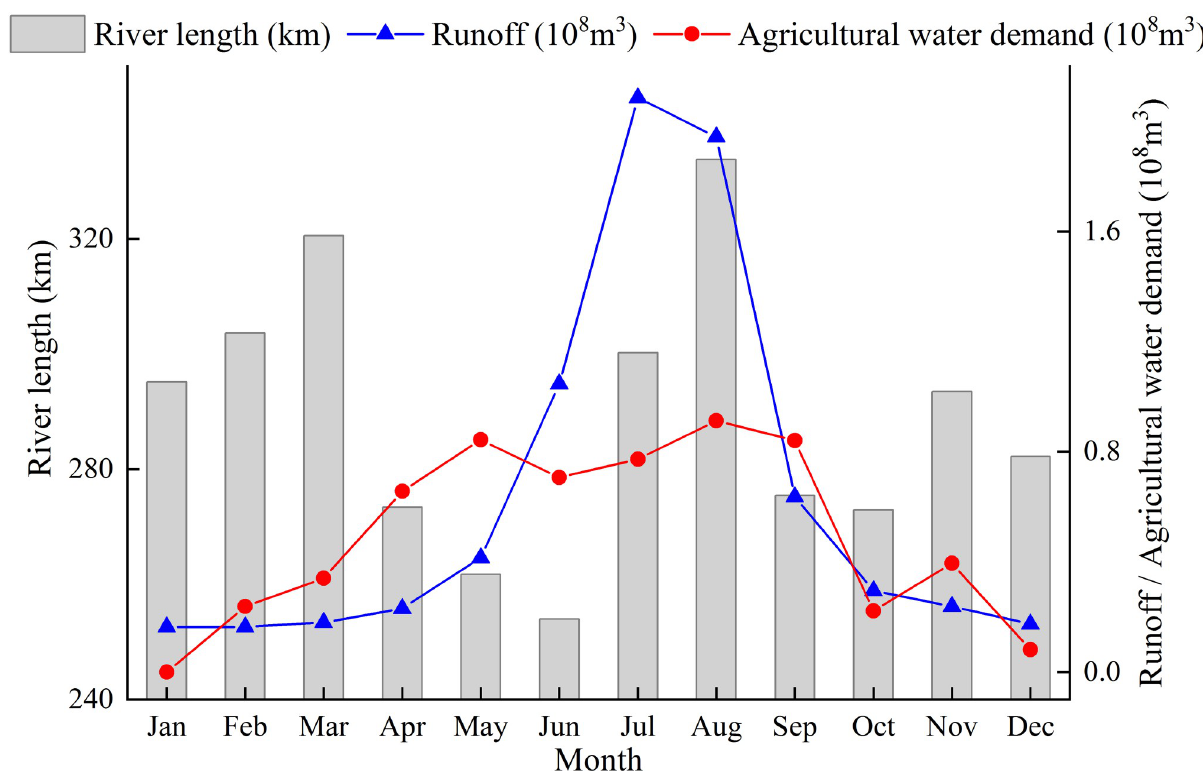
Fig 12. Observed intra-annual changes in lower reach river length (20-year average), upper reach runoff (14-year average) and middle reach agricultural water demand (in 2009) of the Keriya River.